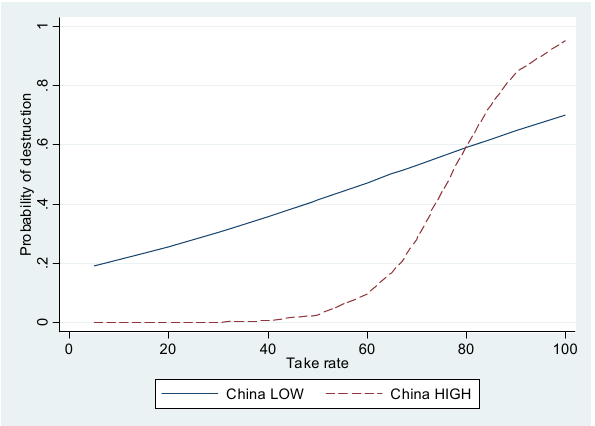
Figure 2. Take rates and probability of destruction in CHINA LOW and CHINA HIGH. Note: The figure shows take rate and probability of destruction in CHINA LOW and CHINA HIGH based on binary logit regressions for each treatment separately.